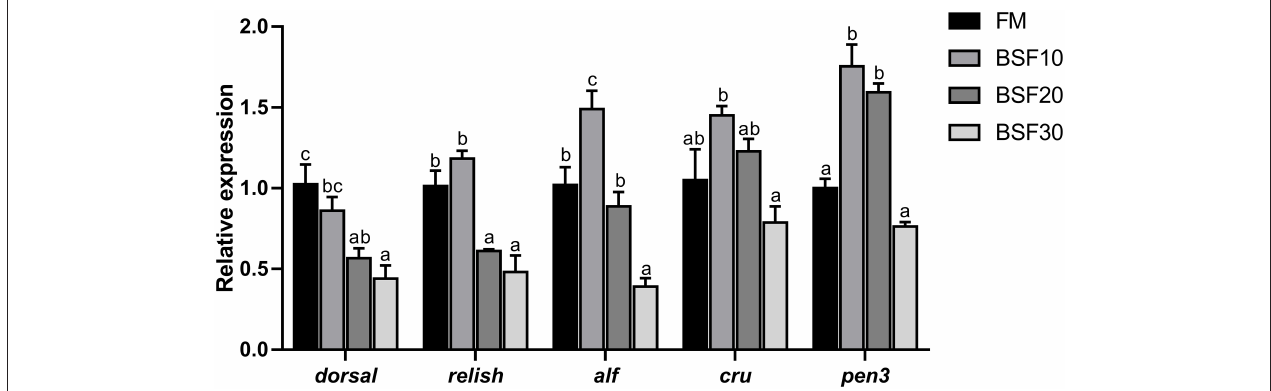
FIGURE 3 | Effect of BSF on mRNA levels of dorsal , relish , alf (anti-lipopolysaccharide factor), cru (crustins), and pen3 (penaeidins 3) in the intestine of L. vannamei . Vertical bars represent the mean ± SEM ( n = 3). Data marked with different letters differ significantly ( P < 0.05) among groups based on Tukey’s HSD test.